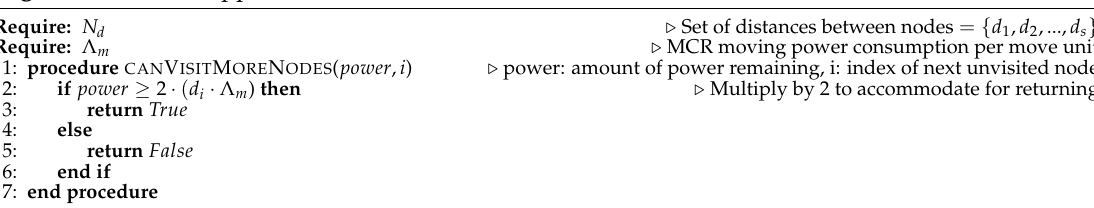
Algorithm 3 Naive approach for CAN V ISIT M ORE N ODES